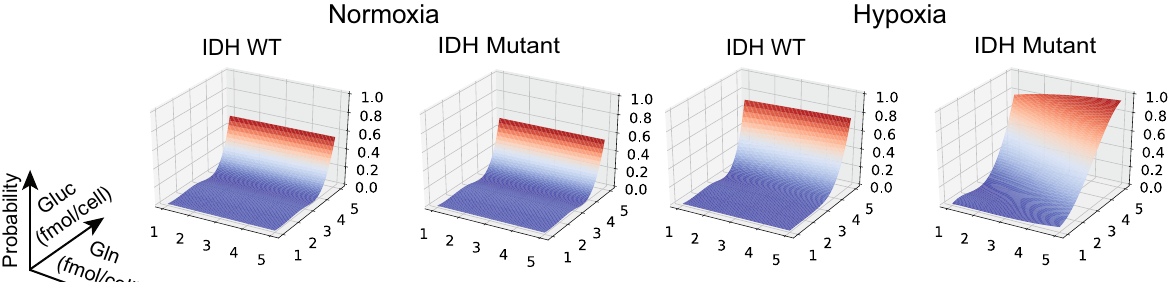
Figure 4. Probability of lactate saturation as a function of initial concentration of nutrients. The PRISM models were instantiated with corresponding phenotype and conditions as in the experimental models. Glucose and glutamine initial concentrations are varied over 1–5 (fmol/cell) and all other species are set to 0. The model checking problem was expressed as computing the probability of reaching a state in which lactate is saturated at a given point in